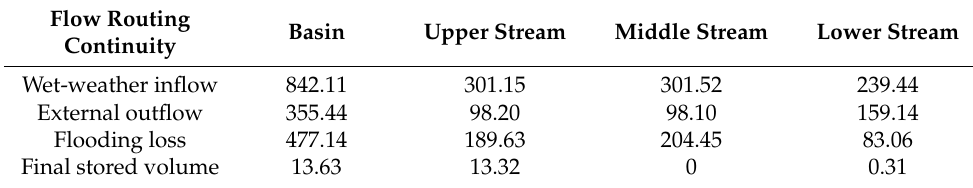
Figure 2. The flow scheme.